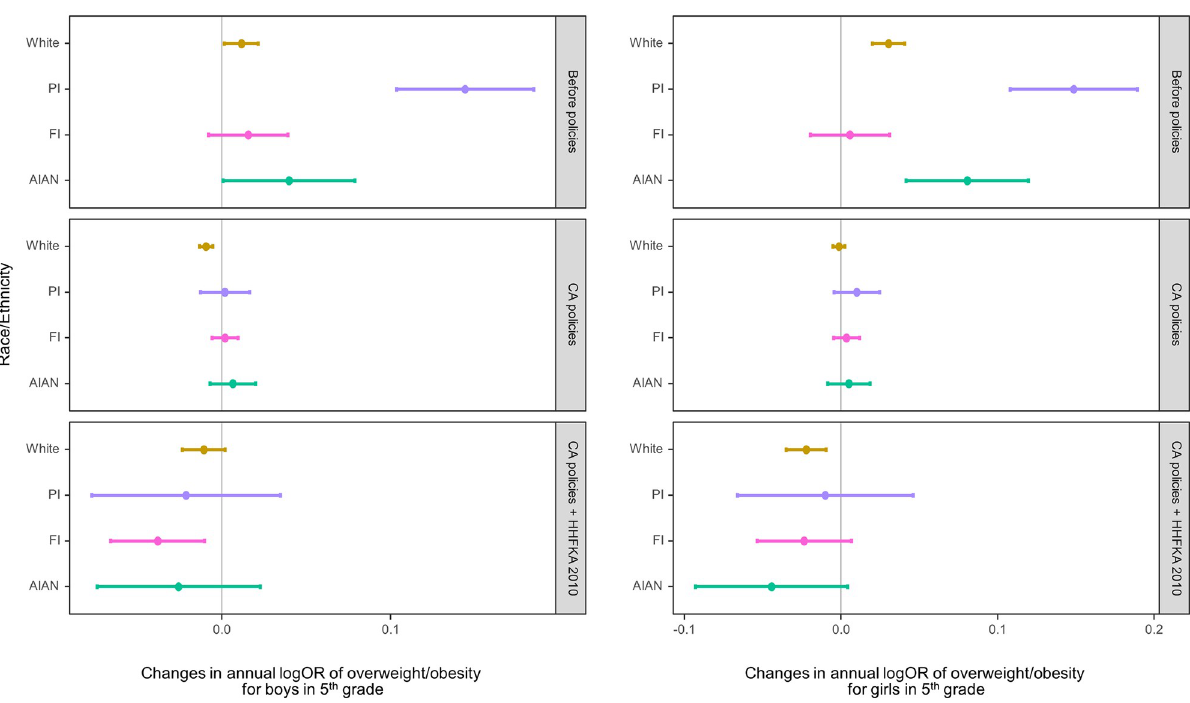
Fig 2. Adjusted change in the log odds of overweight/obesity per year within the periods 2002–2004 (baseline, no policies in effect), 2005–2012 (after CA policies and before HHFKA 2010), and 2013–2016 (CA policies plus HHFKA 2010) among fifth graders by sex. The dots indicate the point estimates of the yearly changes in the log odds, and the whiskers show the 95% confidence intervals. AIAN, American Indian/Alaska Native; CA, California; FI, children of Filipino origin; HHFKA 2010, Healthy, Hunger-Free Kids Act of 2010; OR, odds ratio; PI, children of Pacific Islander origin; W,